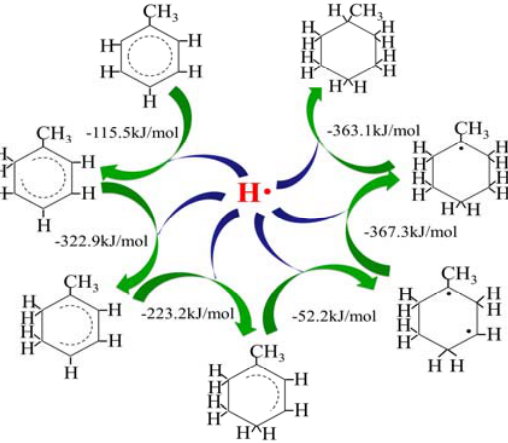
Figure 5. Reaction scheme of the toluene hydrogenation process.